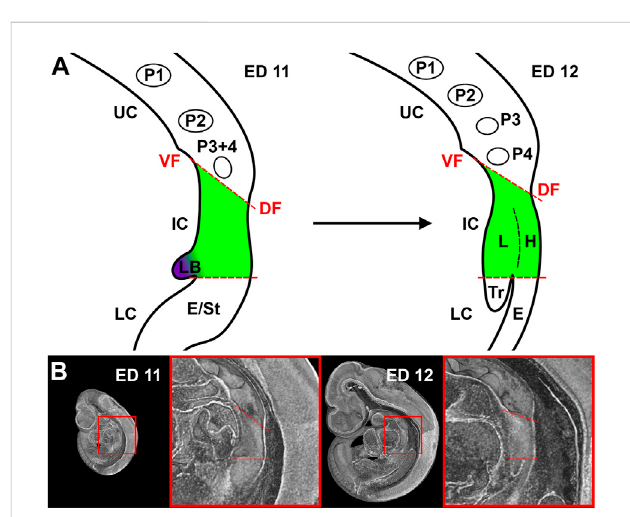
FIGURE 2 Representation of our de fi nition of the foregut compartments. (A) Schematicdrawingofasagittalplaneoftheforegutinratembryosatday 11 and 12. UC, Upper compartment; IC, Intermediate compartment; LC, Lower compartment; VF, Ventral fold; DF, Dorsal fold; P1-4, Pharyngeal pouches; LB, Lung bud;E, Esophagus;St,Stomach; L, larynx; H, Hypopharynx; Tr, Trachea. (B) Representative sagittal plane of reconstructions of rat embryos with enlarged area of